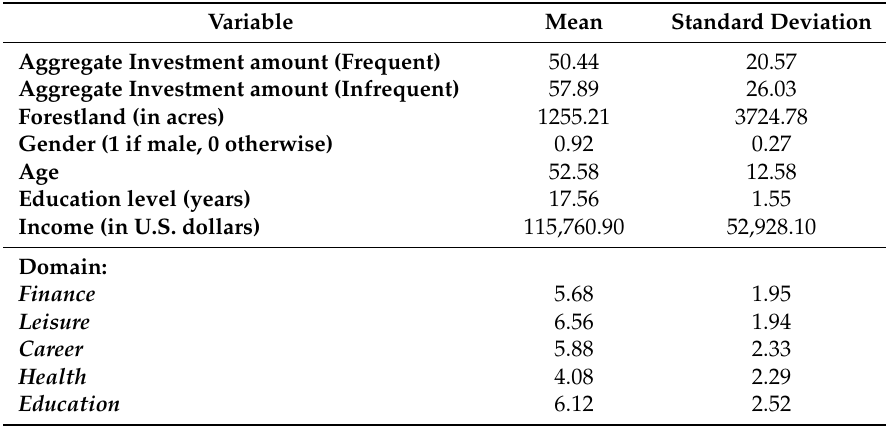
Table 1. Summary statistics of selected